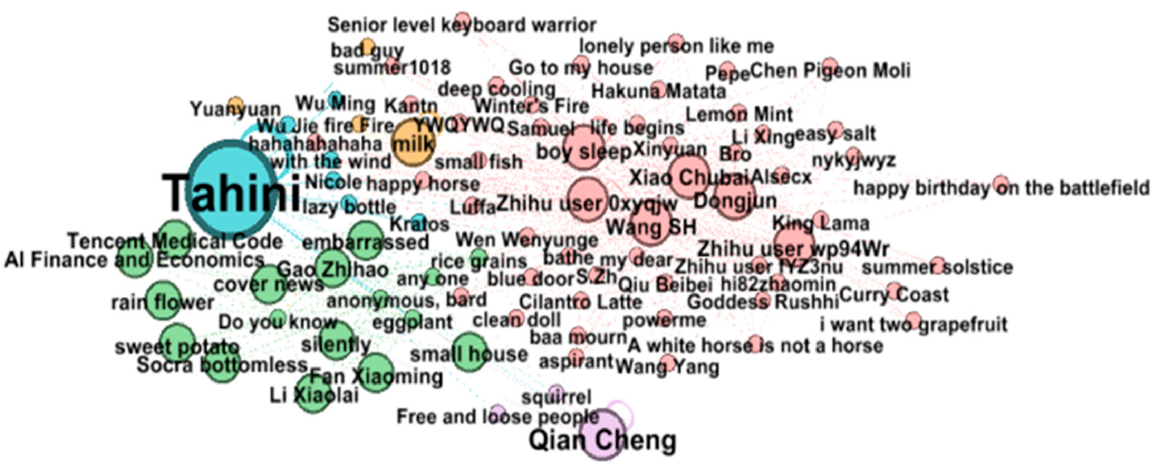
Figure 2. User community structure on food safety.